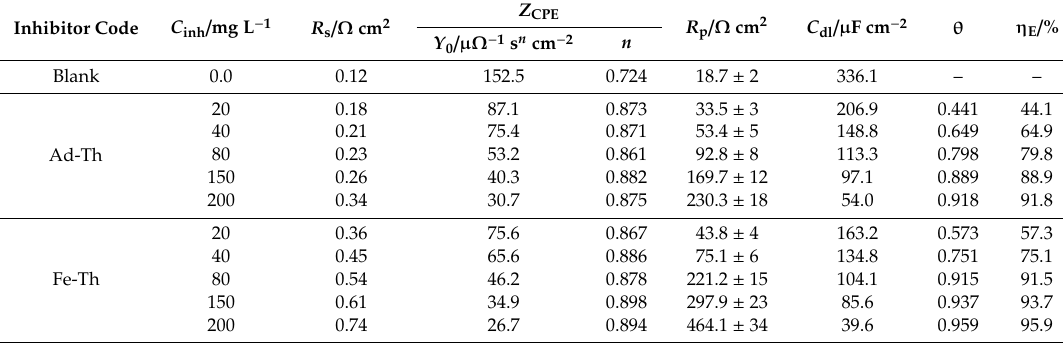
Table 2. EIS parameters and protection capacity of C-steel in 1.0 M HCl in the lack and existence of various concentrations of thiocarbohydrazones derivatives at 50 ◦